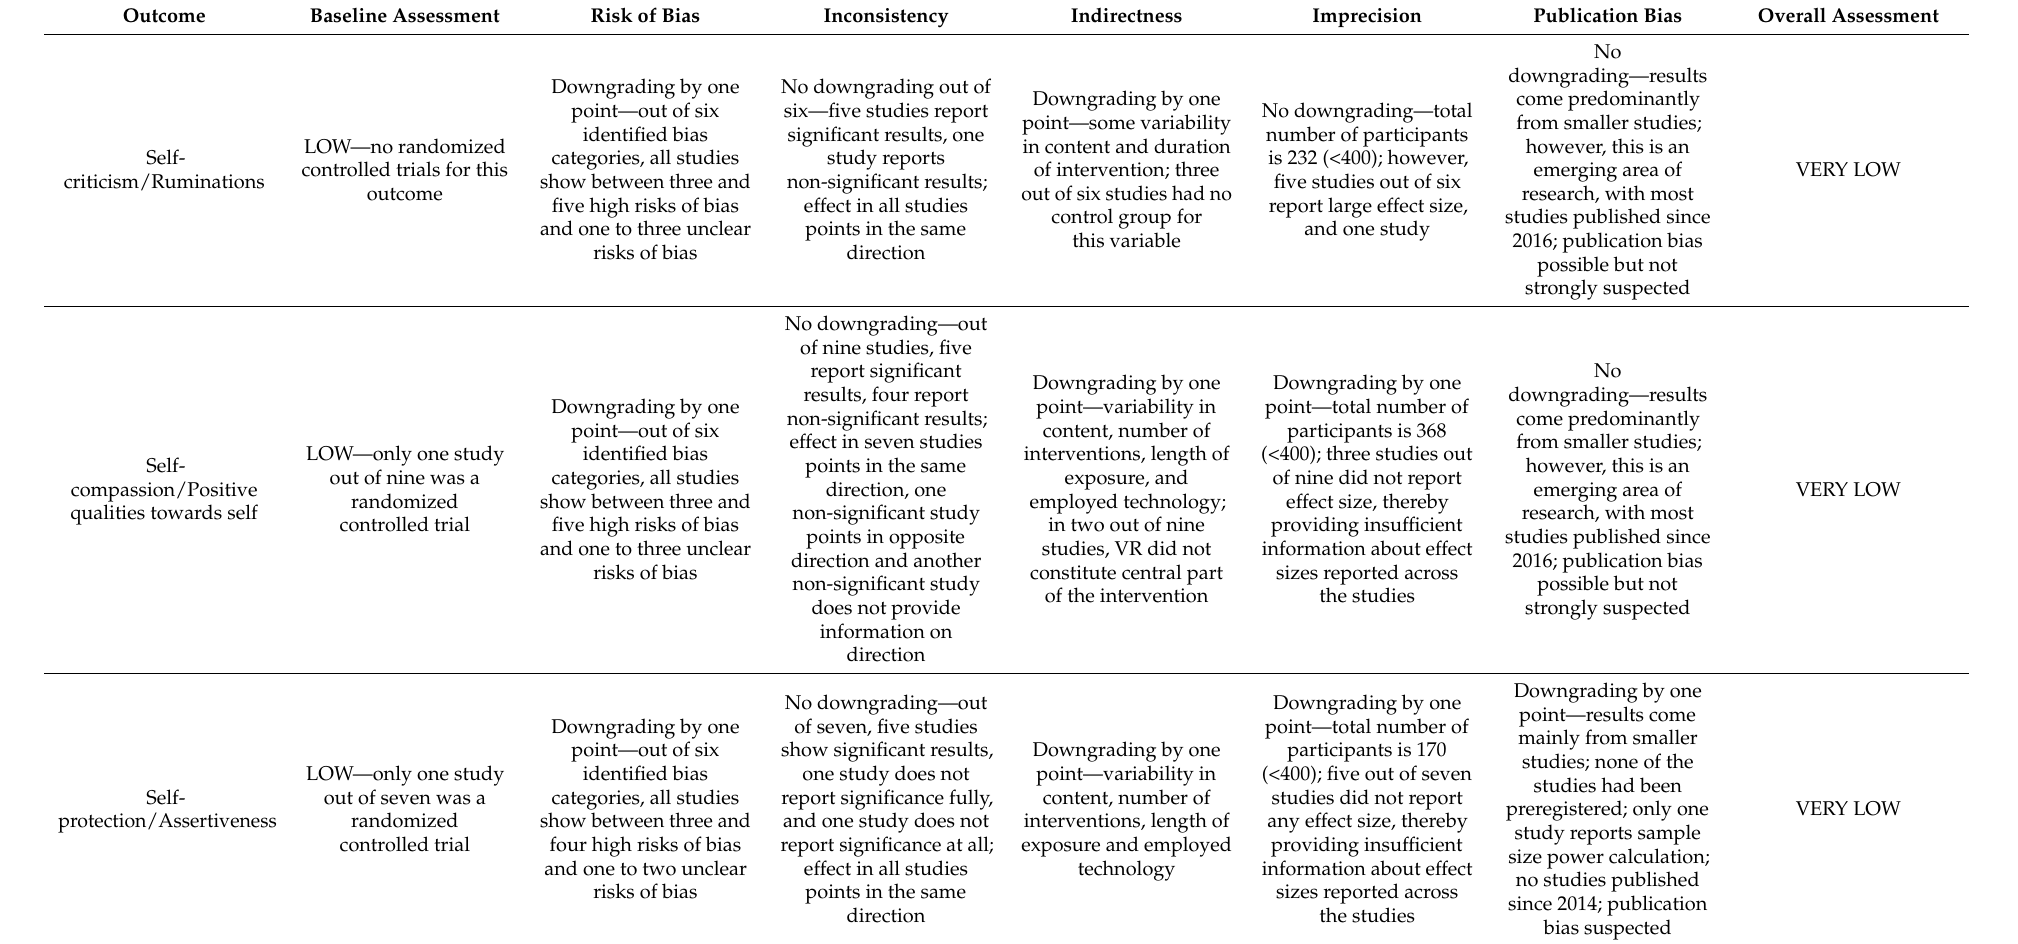
Table 4. GRADE certainty assessment for measured